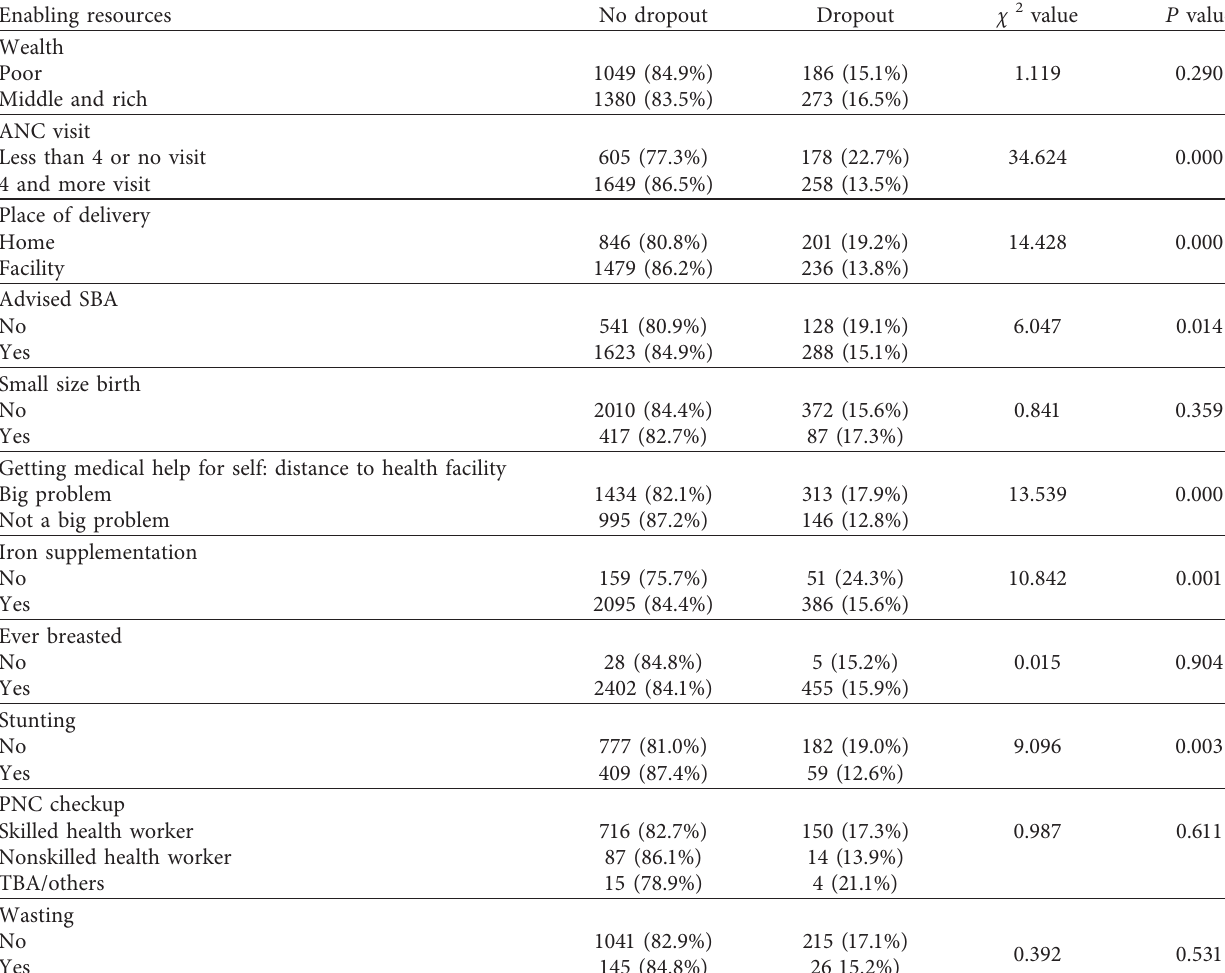
Table 4: Cross tabulation between enabling resources and DPT1 Vs DPT3